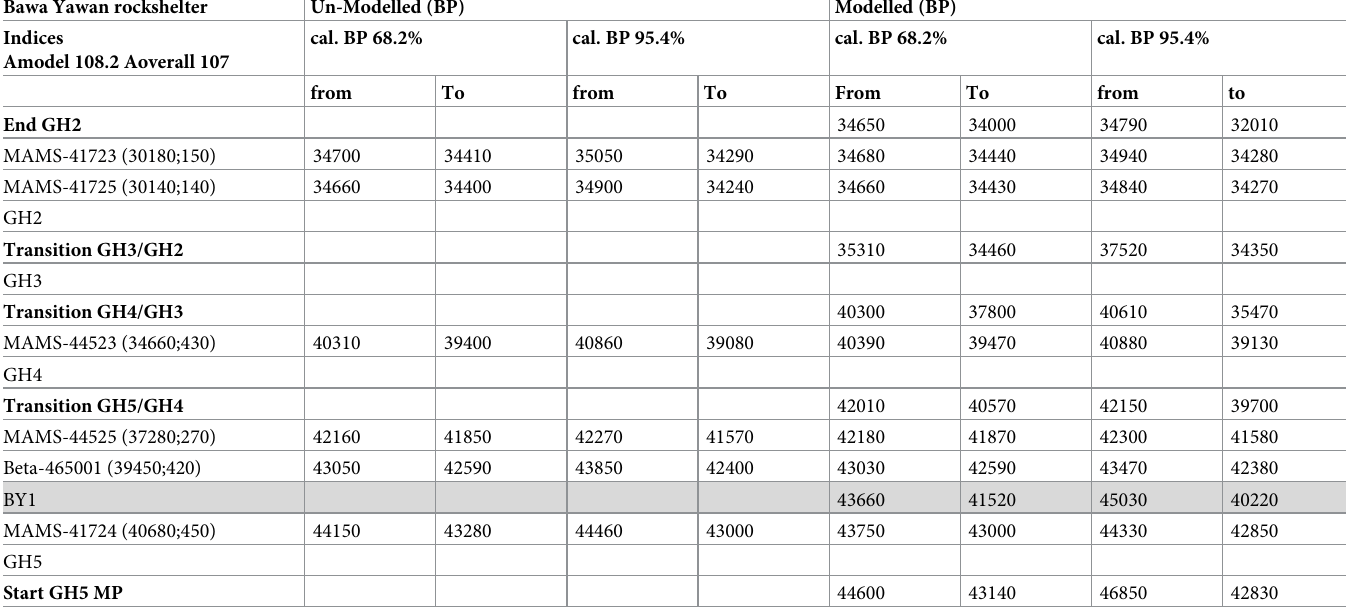
Table 6. Bayesian Modelled calibrated ages and boundaries of Model 1 provided by the IntCal20 using OxCal 4.3 program [43, 49]. In red is the indirect date of the BY1 tooth provided by the ‘date’ command in OxCal. Bawa Yawan